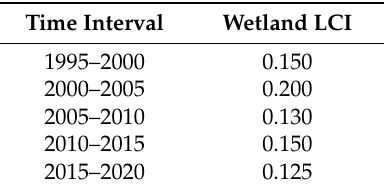
Table 4. Landscape change index (LCI) from 1995 to